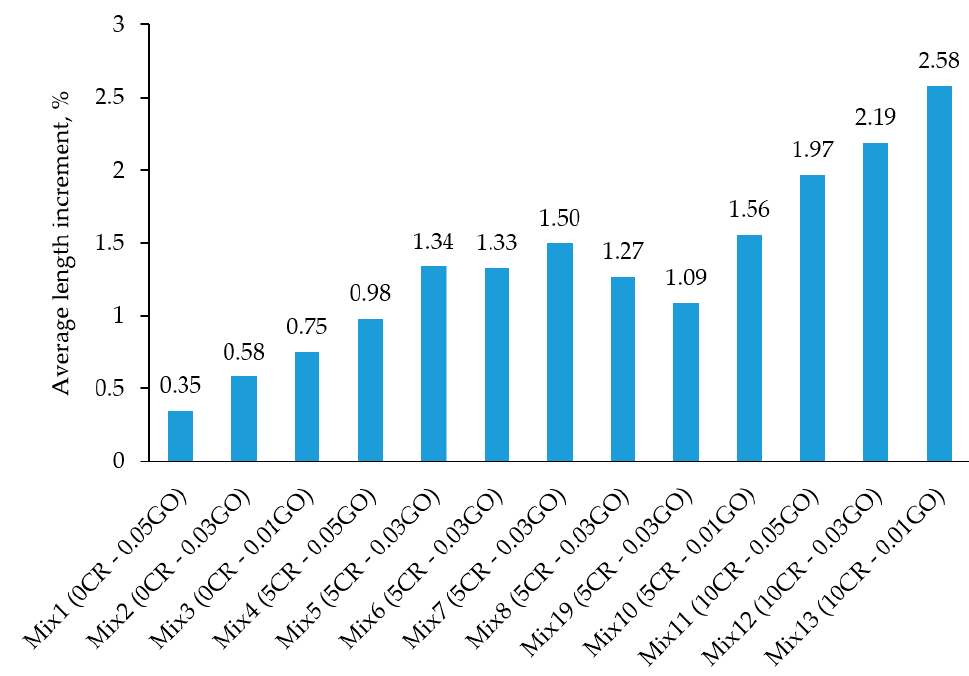
Figure 10. Sulphate attack test results of rubberized ECC with GO after 28 days.